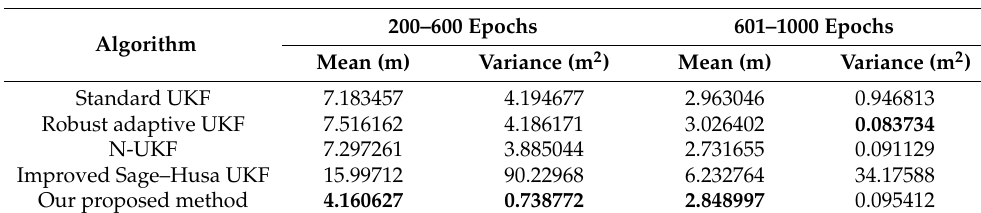
Figure 5. Position tracking errors for Case 2. Table 2. Position tracking errors of the different algorithms for Case 2. The bold numbers stand for the minimum.